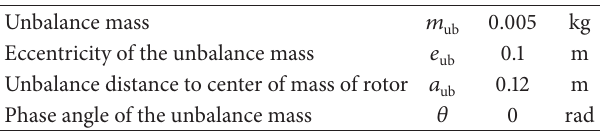
Table 3: Unbalance mass parameters of the rotor and support properties.